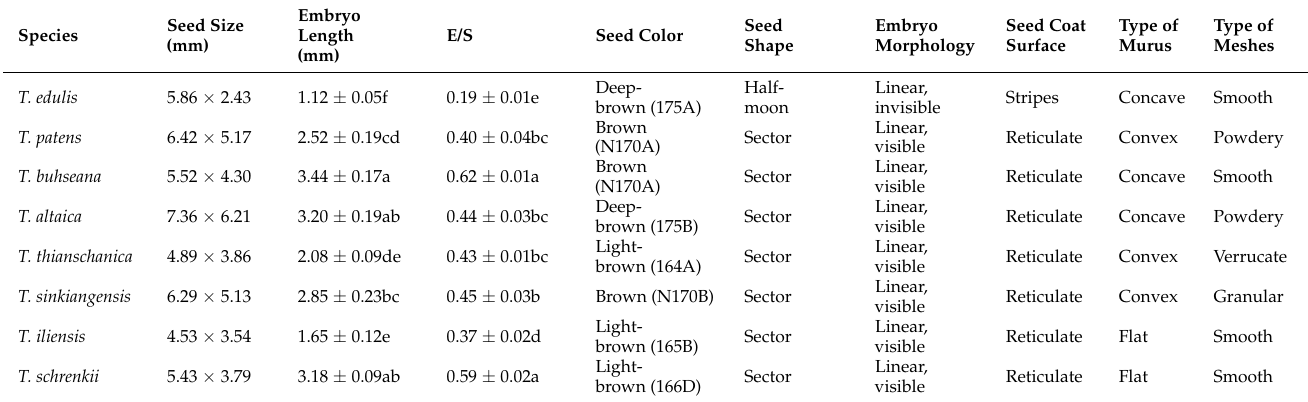
Note: Data are the mean ± SE, different lower-case letters within the same column indicate a significant difference at p < 0.05 with Duncan’s multiple range